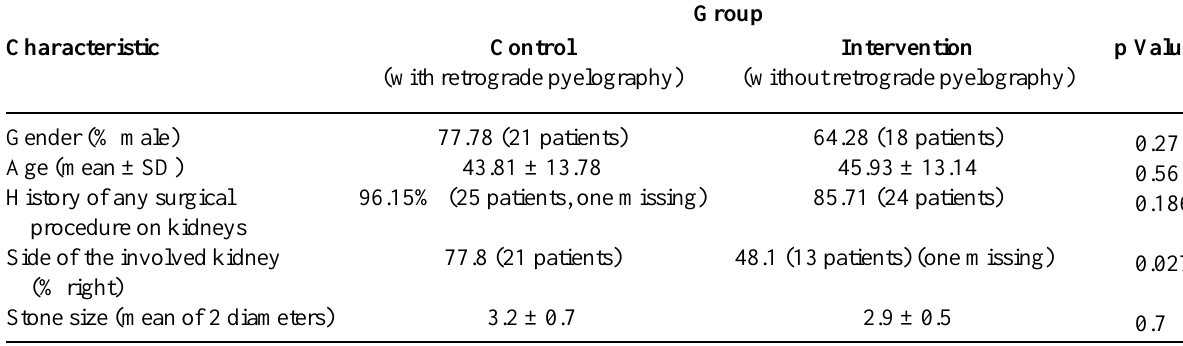
Table 1 – Demographic characteristics of the 2 studied groups.